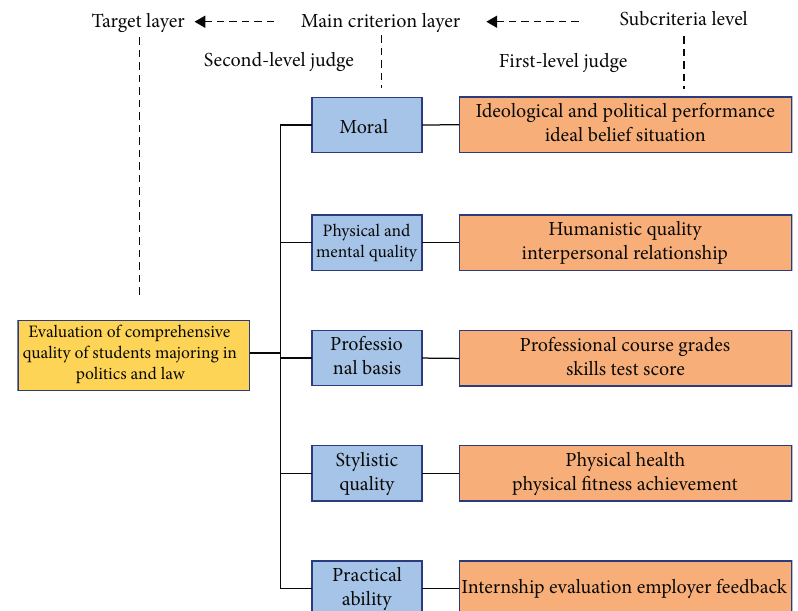
Figure 4: Level fuzzy judgment diagram.